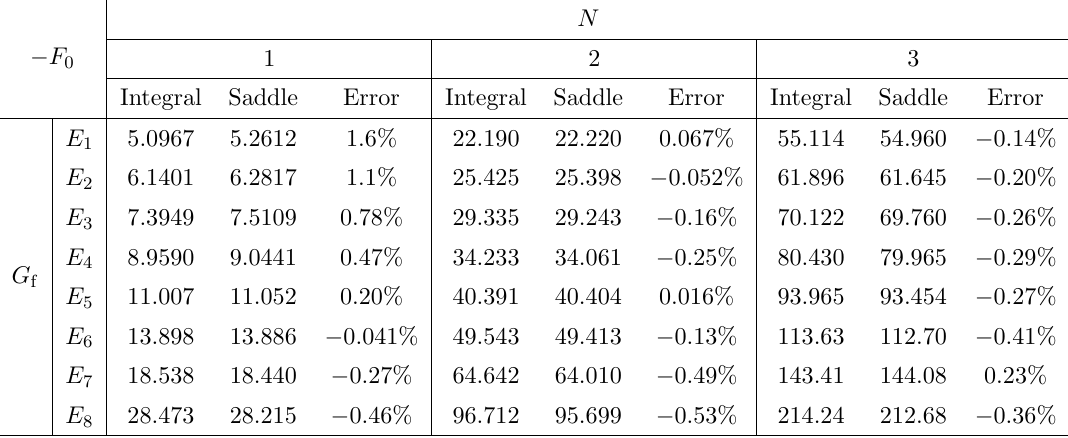
Table 2 . The perturbative values of the round sphere free energy (cid:0) F Seiberg theories, computed by numerical integration and by the saddle point